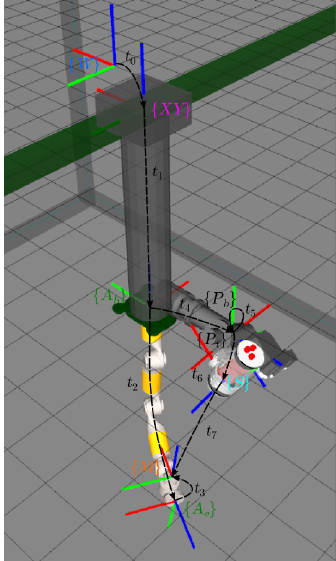
Figure 9. Schematics of the frames involved in the calibration process of the eight DoF manipulator. Each block/actuator has a different colour: { W } (blue) is the world reference frame; { XY } (pink) is the position of the plotter head; { A b } is the base; { A ee } (green) is the end-effector of the robotic arm; { M } (red) is the frame of a marker used for the calibration; { P b } is the base; { P t } (black) is the rotated axis of the pan and tilt actuator; and finally, { S } (blue) is the frame of the laser scanner. Each one of the t i represents the transformation between the corresponding reference frames.